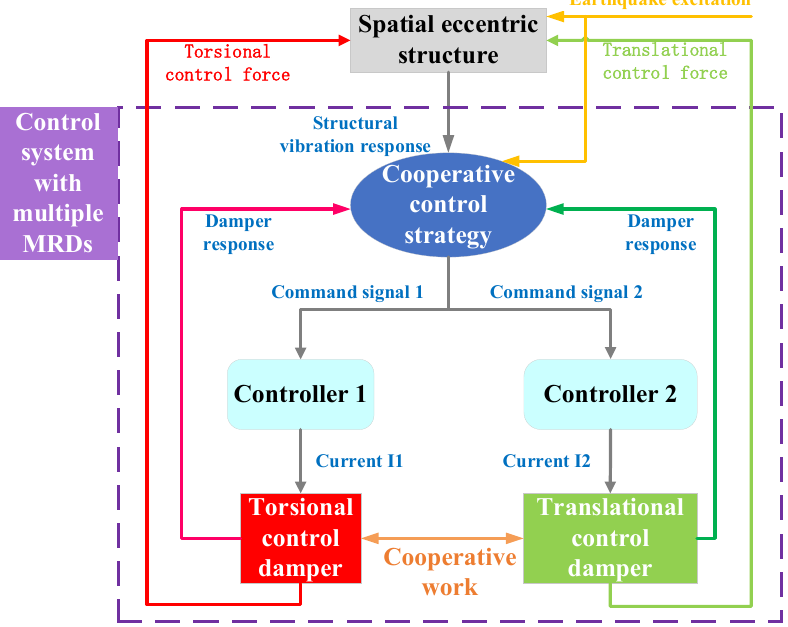
Figure 10. Work flow diagram of the control system with multiple MR dampers.